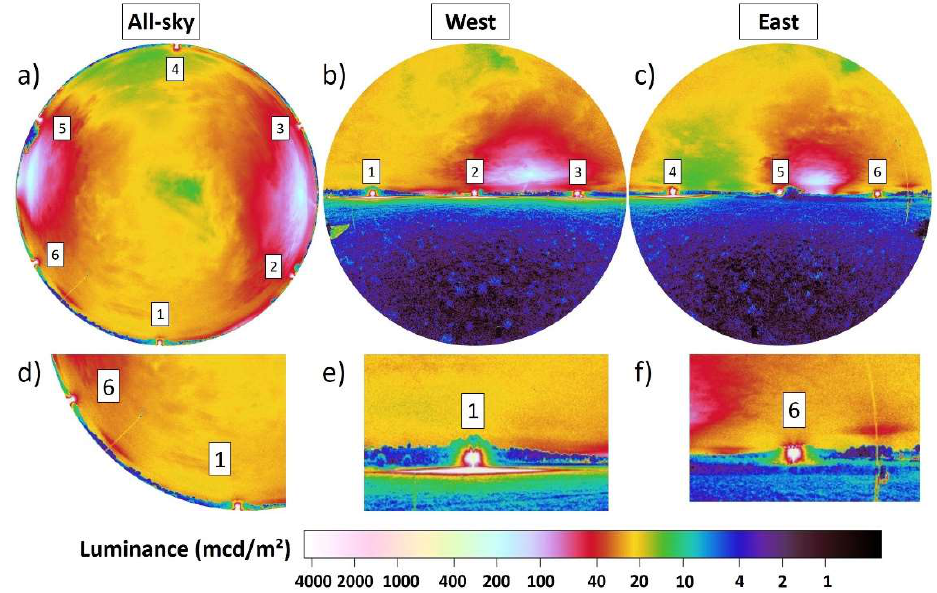
Figure 3. Luminance maps obtained in the center of six sodium vapor street lamps (labelled 1–6) that were arranged in a circle. ( a ) Shows the all-sky data, ( b ) vertical plane data towards the West and ( c ) vertical plane data towards the East. Panels ( d ), ( e ), and ( f ) show zoom-in of the luminance maps, to highlight the reflected light just below the horizon. The difference between the two lamps in ( e ) and ( f ) is not perceivable in the all-sky image in ( d ).